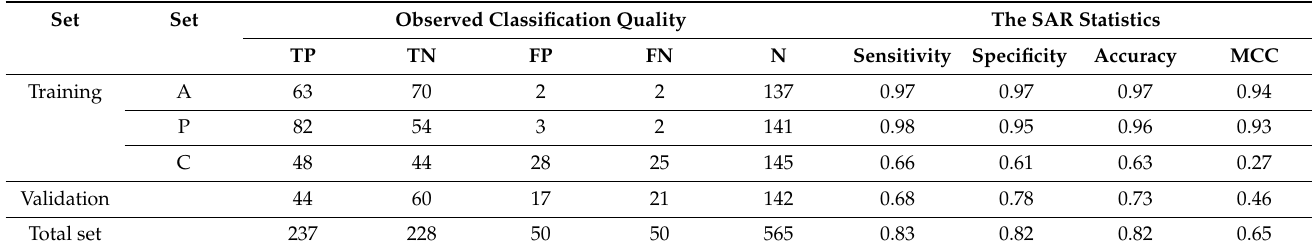
Table 3. The statistical quality of model observed for the second optimal descriptor with the first version of the Monte Carlo optimisation of the correlation weights.